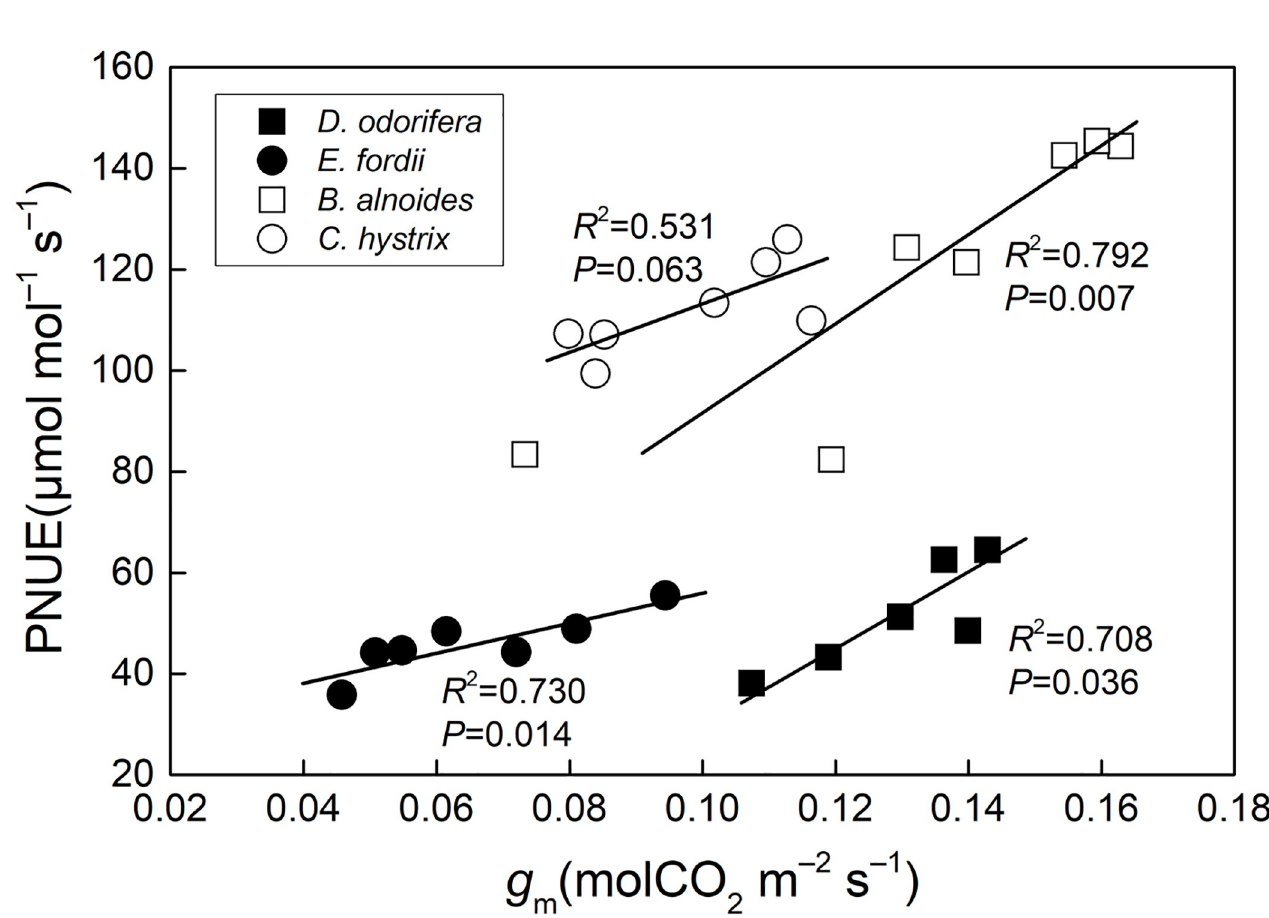
Fig 1. Regression analysis of mesophyll conductance ( g m ) with photosynthetic-N use efficiency (PNUE) in four species seedling leaves. The determination coefficient ( R 2 ) and P -value were also shown. The lines fitted separately for four species were significantly different ( P < 0.05) according to the result of a one- way ANCOVA with PNUE as a dependent variable, tree species as fixed factors, and g m as a